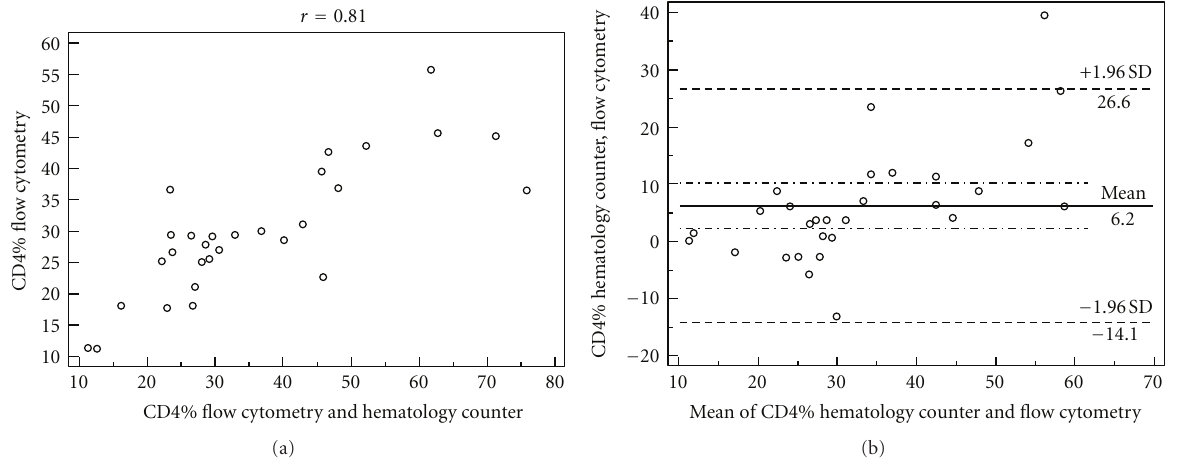
Figure 3: Correlation of percentage values of CD4+, P < 0 . 05 (a) and limits of agreement between the values estimated by Bland-Altman analysis (b) obtained by the hematology counter and the flow cytometer in the stratum of CD4 count > 500 cells/mL.